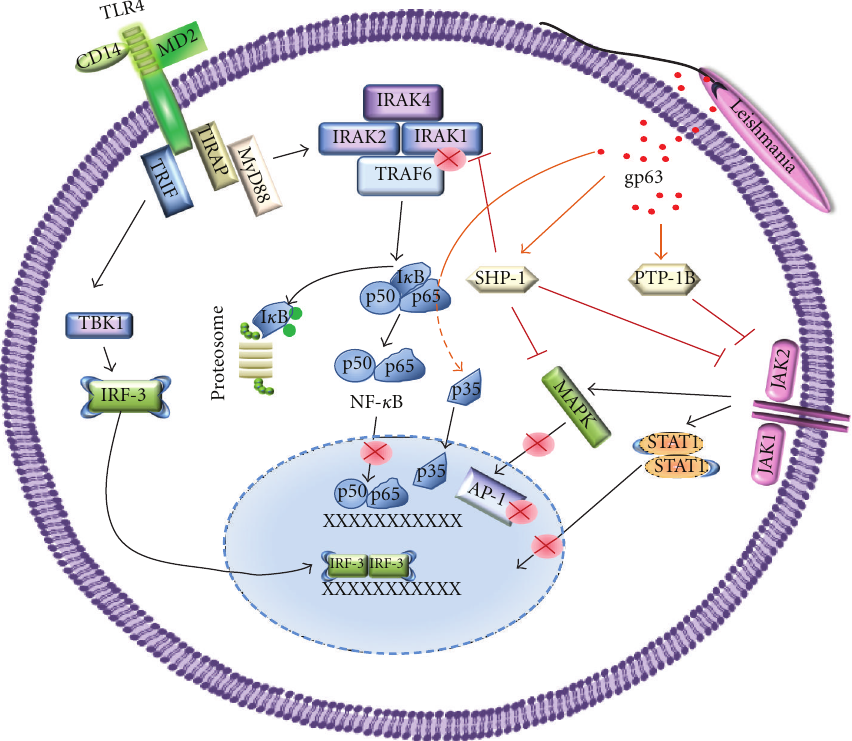
Figure 1: Downregulation of macrophages signalling by Leishmania infection. Leishmania infection modulates phosphatases (SHP-1 and PTP- 1B) activity by mechanism involving the metalloprotease gp63. SHP-1 was found to interact with IRAK-1, a key kinase involved on TLR- triggered signaling pathway. Whereas, both SHP-1 and PTP-1B are involved in the downregulation of IFN γ -induced pathway (JAK/STAT1) as well as MAPK activation. In addition, transcription factor such as NF- κ B and AP-1 are cleaved/degraded in part by Leishmania gp63. Orange arrows indicate gp63 involved modulation; black arrows indicate activation; red abrogated lines indicate